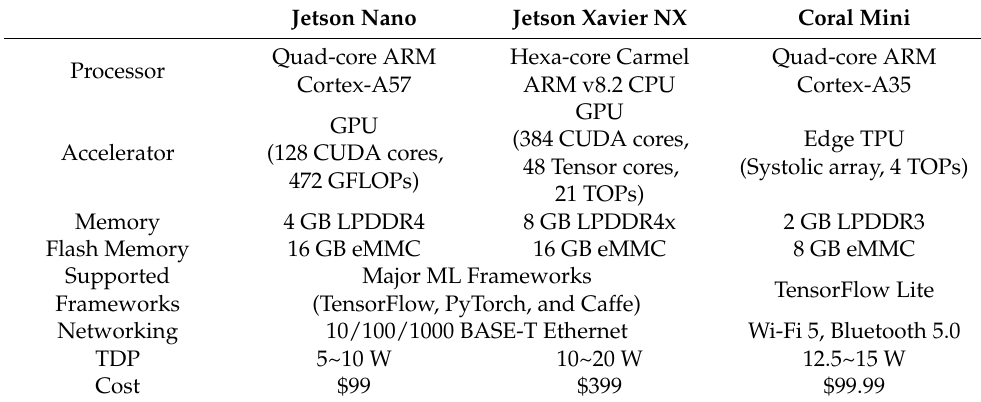
Table 1. Specifications of NVidia Jetson Nano, NVidia Jetson Xavier NX, and Google Coral Mini. Jetson